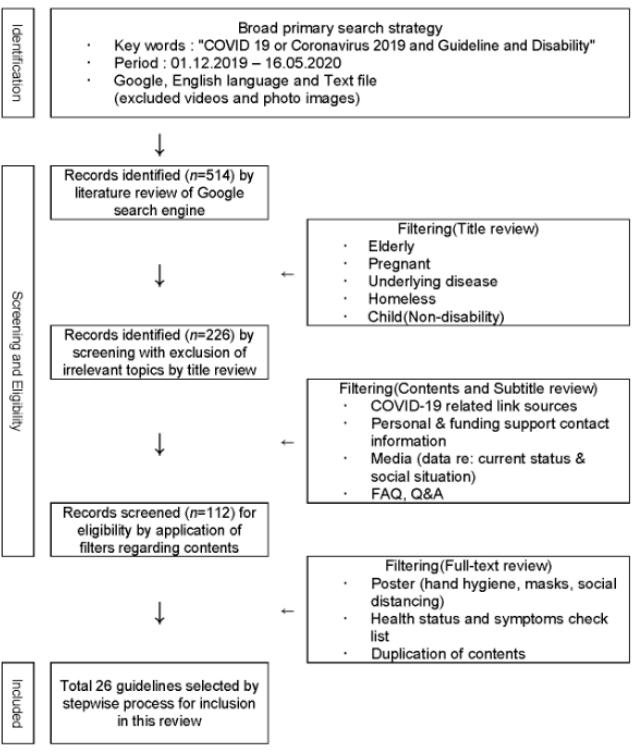
Figure 1. Flow diagram.